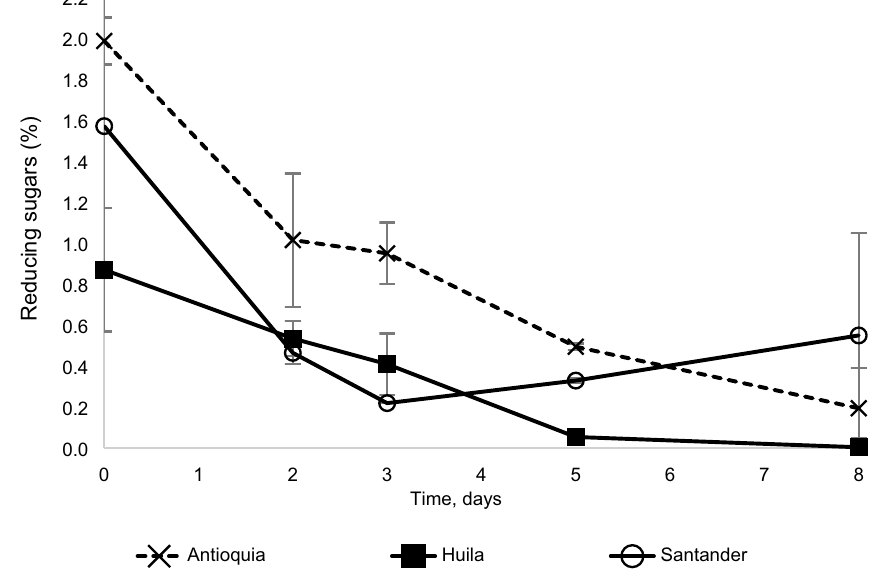
Figure 4. Dynamics of the content of reducing sugars during cocoa fermentation in three contrasting